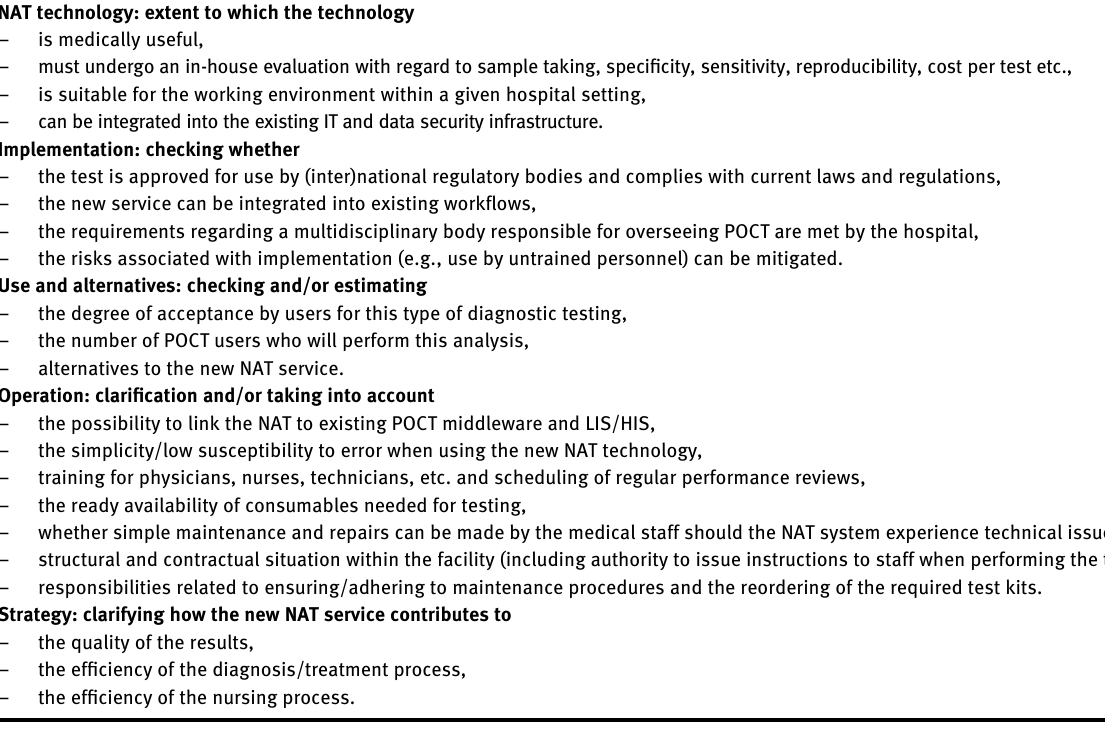
Table  : Preanalytical aspects of near-patient nucleic acid testing